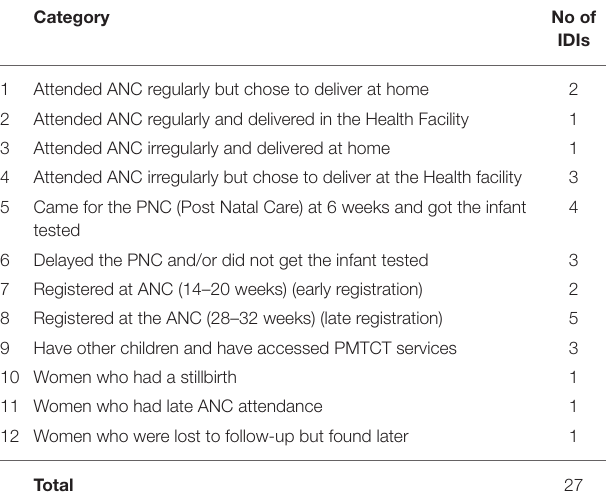
TABLE 1 | Participants IDI categories.